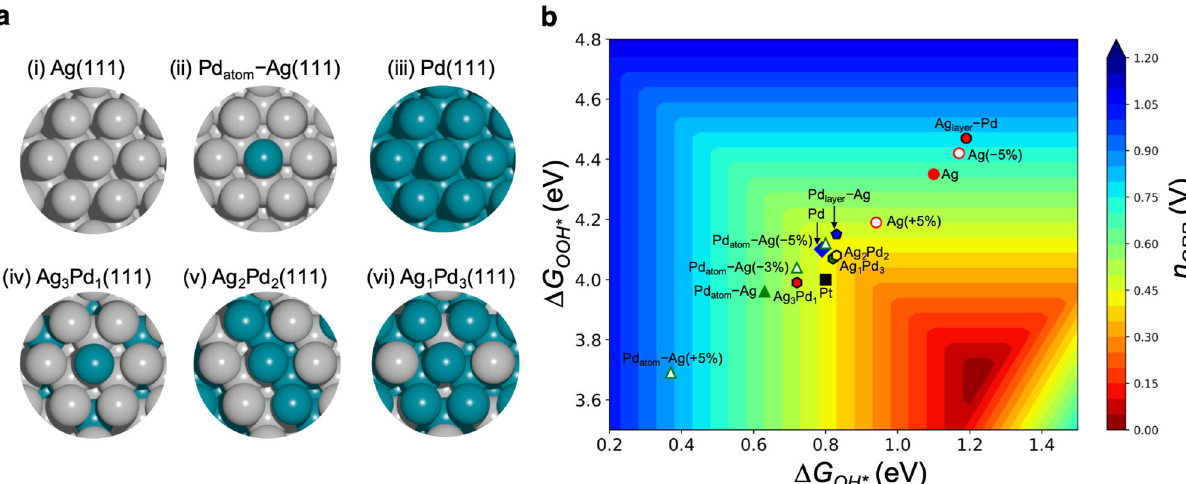
Fig. 3 DFT-calculated ORR activity on Ag-Pd active site motifs. a Ag-Pd active site models investigated by DFT for their effect on ORR activity: (i) Ag, (ii) Pd atom – Ag, (iii) Pd, (iv) Ag 3 Pd 1 , (v) Ag 2 Pd 2 , and (vi) Ag 1 Pd 3 . All the considered surfaces are (111) facets. The identi fi ed most active sites are: (i) Ag top